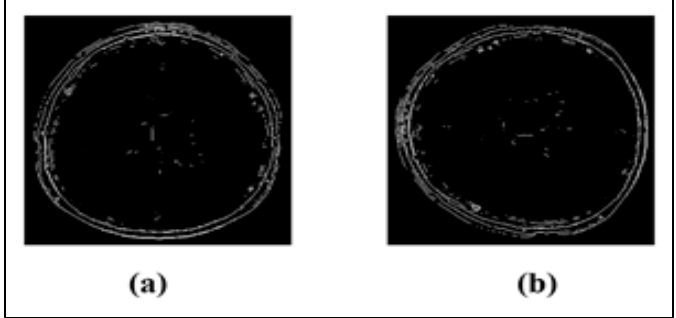
Figure 4. ( a ) Output of source test case E(Im); ( b ) output of follow-up test case E(C(Im)).